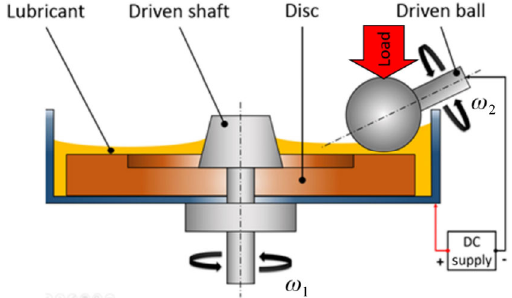
Fig. 3 Schematic representation of MTM contact tribopair with excitation circuit.